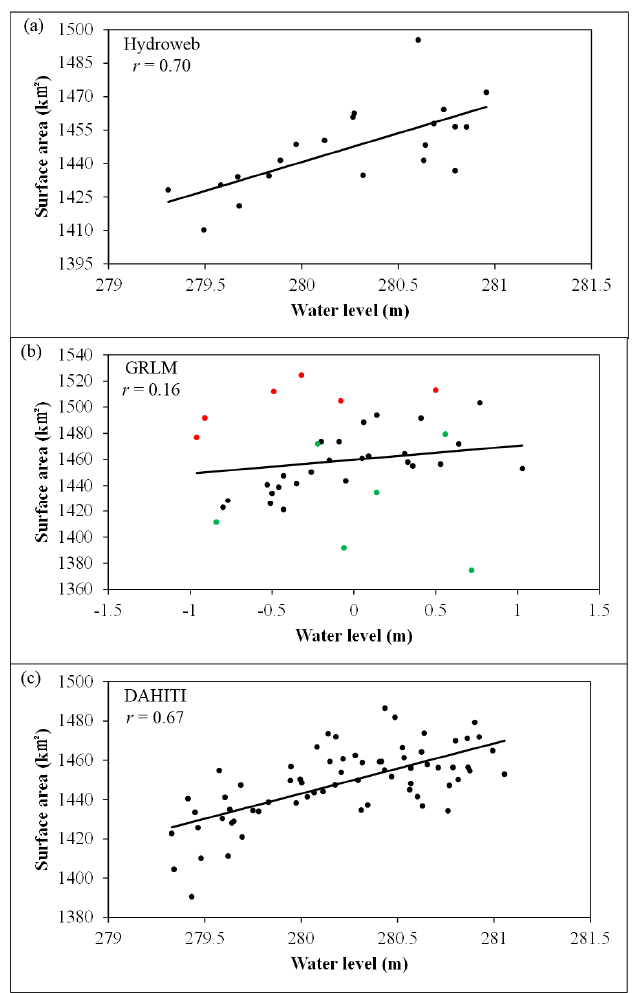
Figure 6. Scatterplots of the water surface area extracted from Landsat images and water level retrieved from: Hydroweb ( a ); GRLM ( b ); and DAHITI ( c ) products. The black, red and green colors in GRLM product represent OSTM, Jason-1 and T/P dataset, respectively.